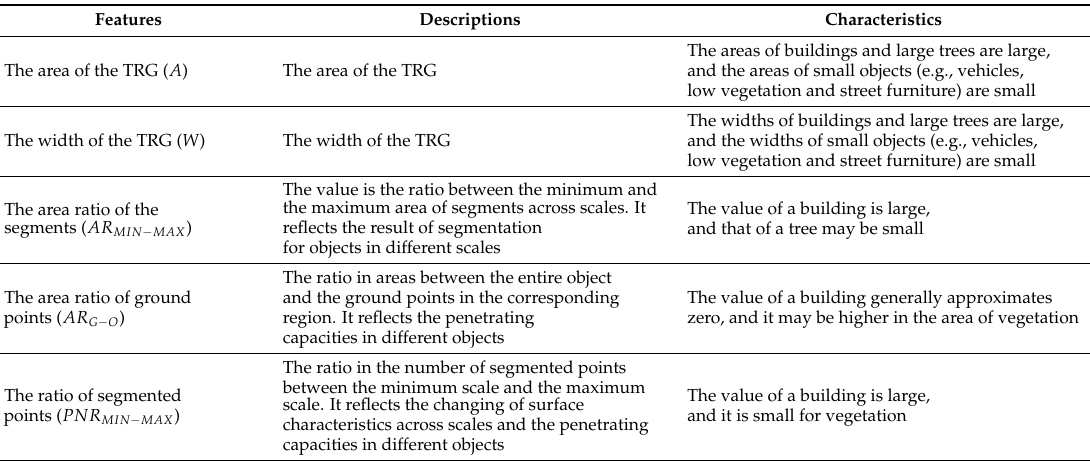
Table 1. Five features based on the